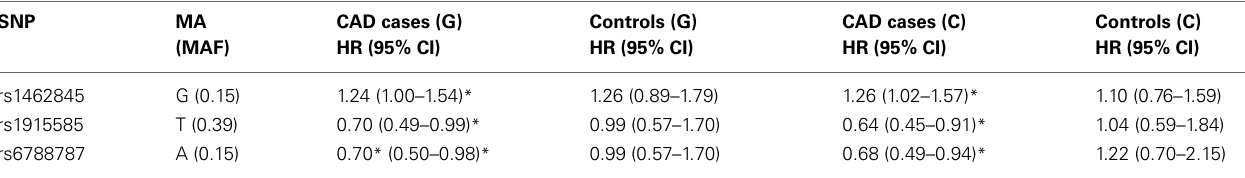
SNP, single nucleotide polymorphism; MA, minor allele; MAF, minor allele frequency; (G), main genotype model; (C), covariate model; HR, hazard ratio; CI, confidence interval; * p < 0.05.